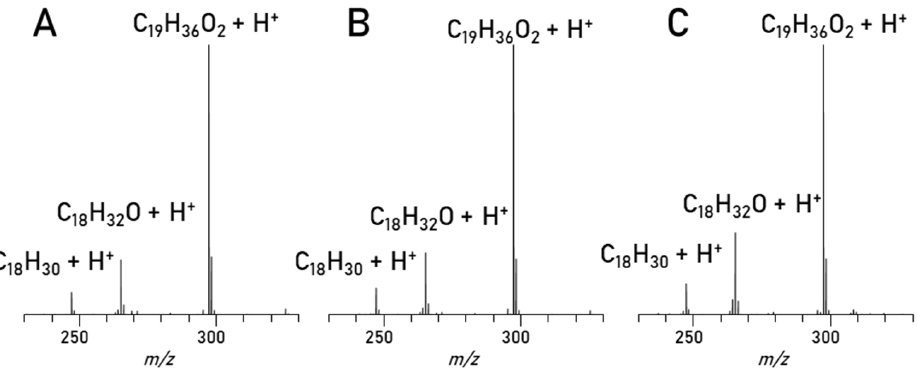
Figure 6. Spectra of C18:1 Peak: A: RME Min: 2.46–2.73, B: Blend Min: 2.62–2.94, C: Methyl oleate standard full scan.